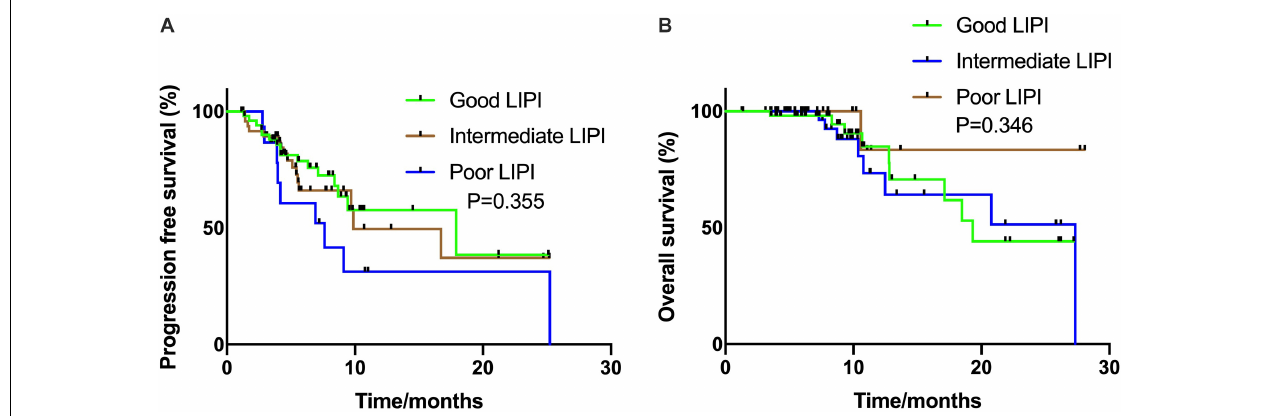
FIGURE 2 | Kaplan Meier estimates of progression-free survival (PFS) and overall survival (OS) according to the Lung Immune Prognostic Index (LIPI) groups in patients with ICIs combination group (A) PFS in the ICIs combination group ( P = 0.355); (B) OS in the ICIs combination group ( P =